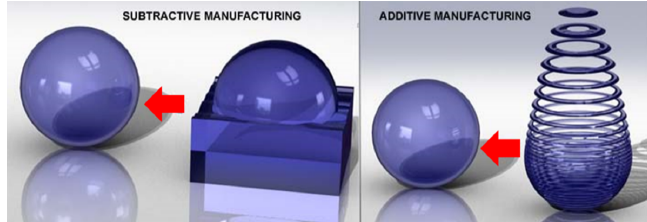
Figure 1. Schematic illustration showing the differences between subtractive ( left ) and additive ( right ) manufacturing [12].